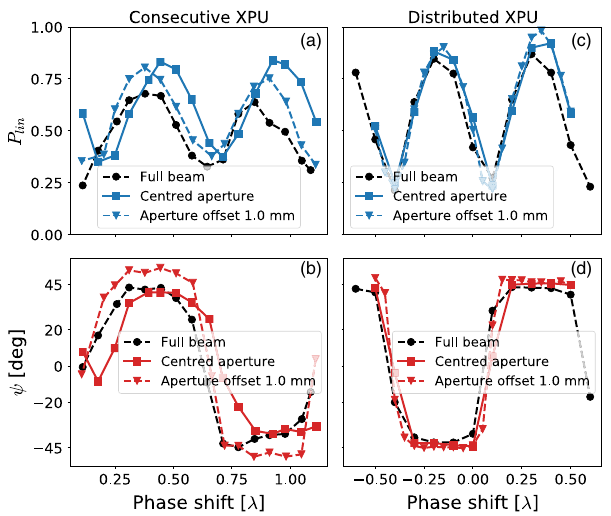
FIG. 14. Degree and direction of the linear polarization component for the circular XPU. Panels (a, b) refer to the consecutive scheme [Fig. 2(b)], while (c, d) refer to the distributed scheme [Fig. 2(c)]. The lines represent the moving average over 30 shots. The data were acquired selecting a 1 × 1 mm 2 aperture, centered on the beam axis. The difference in the absolute value of ψ between the two configurations is only due to the particular settings of the phase shifters in the two measurements, and can be freely varied as reported in Fig. 16. The data for the full aperture case is reported in